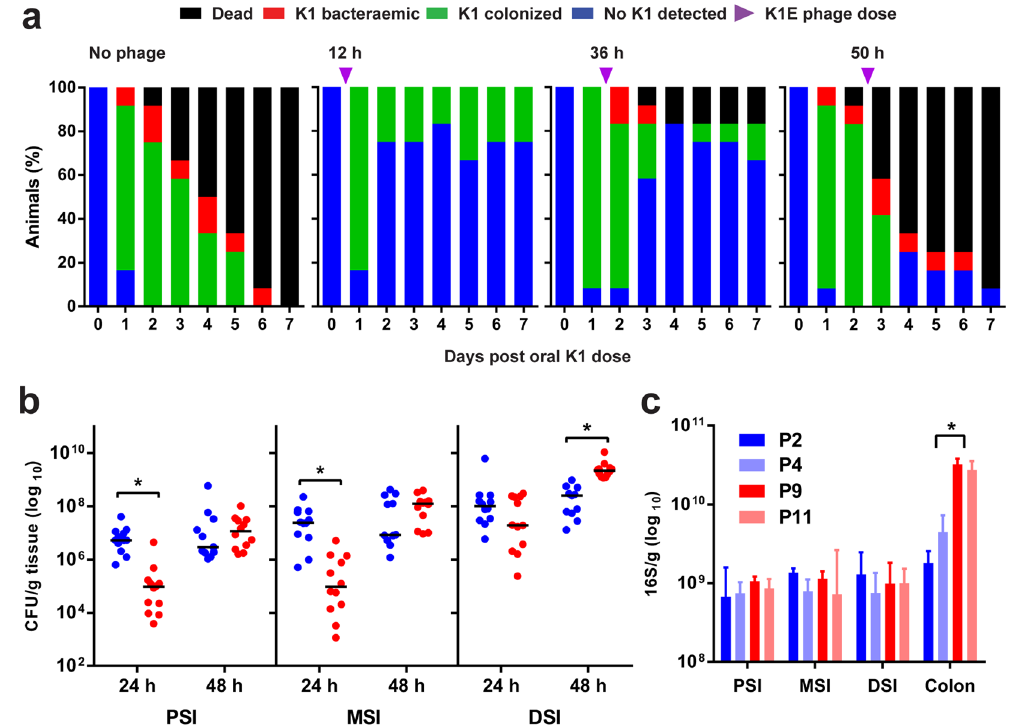
Figure 1. Dynamics of colonization and infection of neonatal rats following an oral dose of E. coli K1. ( a ) Survival, colonization and bacteraemic status of neonatal rats dosed orally with 4–8 × 10 6 CFU E. coli A192PP at P2. Colonized animals were fed vehicle buffer (no phage) or 10 9 PFU K1E bacteriophage 12, 36 or 50 h after receiving colonizing bacteria. n = 12 for each group; data from at least two independent experiments. For bacterial quantification, 2 cm segments of proximal (PSI), mid- (MSI) and distal (DSI) small intestine and colon were excised from P2 and P9 neonatal rat pups. Colonization of small intestinal regions 24 and 48 h after oral dosing of neonatal rats with E. coli A192PP at P2 or P9 was determined by culture-dependent enumeration of E. coli K1 bacteria ( b ); n = 4–12 animals; line is median, * P < 0.05. ( c ) Total bacterial load in small intestinal and colonic tissue segments as determined by qPCR of 16S rRNA genes; median ± range, * P < 0.05 (Tukey’s multiple